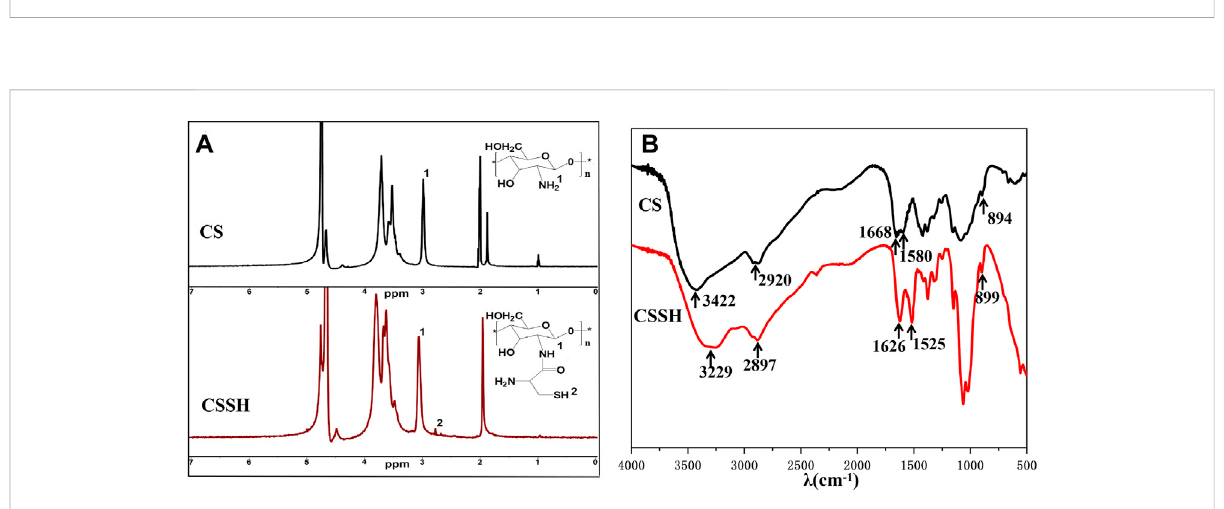
FIGURE 2 1 H NMR spectra (A) and FT-IR spectra (B) of CS before and after modi fi